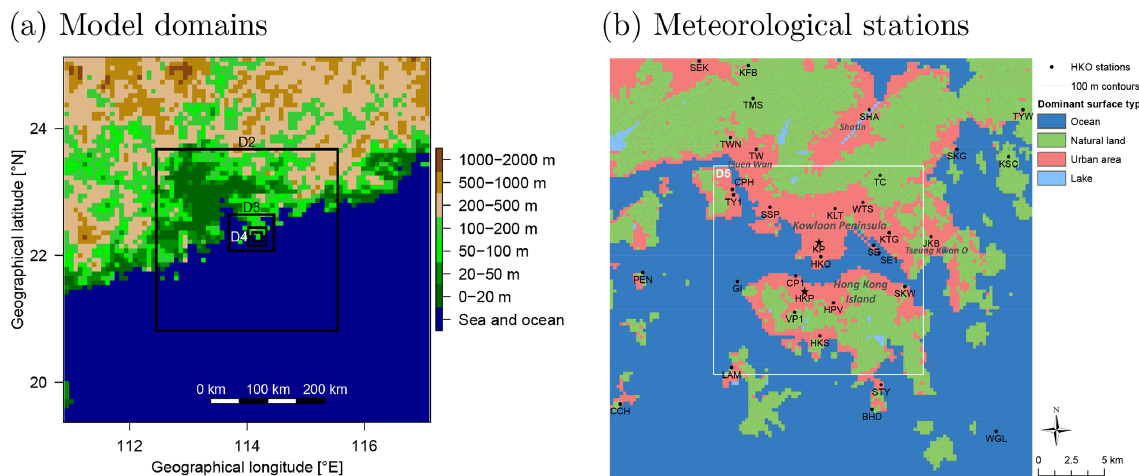
Figure 2. (a) The five nested Meso-NH model domains employed for the high-resolution simulation of the urban climate of Hong Kong. (b) Meteorological stations operated by the Hong Kong Observatory that are located within model domains D4 and D5. Model results will be presented in more detail at the starred stations (KP and HKP).